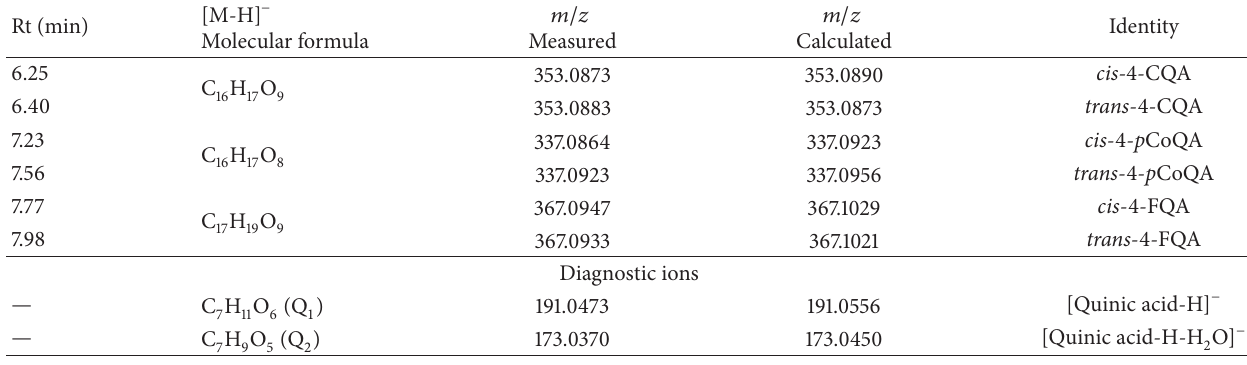
Table 1: The UPLC-QTOF-MS/MS information of the annotated CQA, p CoQA, and FQA from Momordica plants extracts. The diagnostic ions (Q 1 and Q 2 ) used for isomers differentiation are also shown and they were ubiquitous across all the molecules detected. Rt (min)